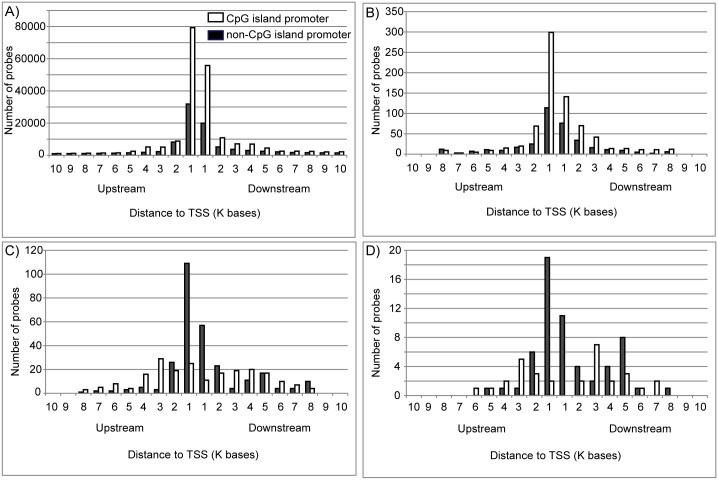
Distribution patterns of the distances between CpG sites and the nearest TSS.Distribution patterns for all 299,261 CpG probes on the HumanMethylation450 BeadChip (A), 1,101 hypermethylated CpG sites for which the nearest gene was down-regulated upon replicative senescence (B), 495 hypomethylated CpG sites for which the nearest gene was up-regulated upon replicative senescence (C), and 90 hypomethylated CpG sites for which the nearest gene was up-regulated upon replicative senescence and related to immune response (D) are shown.